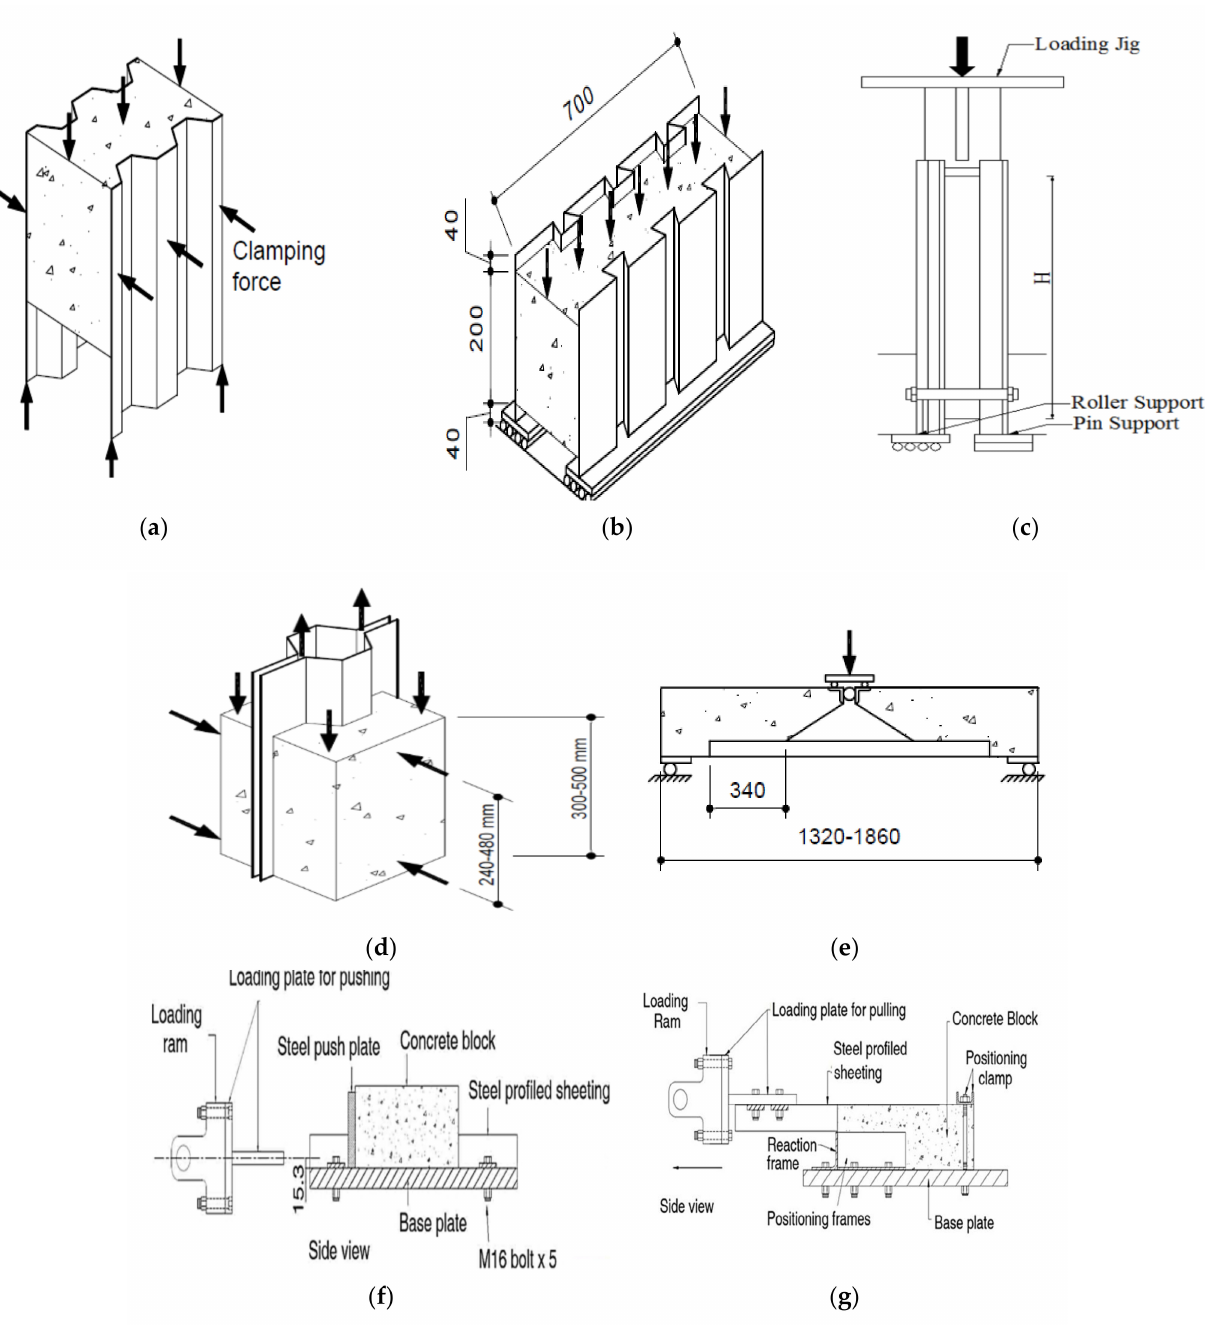
Figure 1. Small-scale test set-ups (dimensions are in mm) . ( a ) Stark (1987). ( b ) Burnet (1998). ( c ) Rana (2016a). ( d ) Daniels (1988). ( e ) An (1993). ( f ) Yi et al. (2021a). ( g ) Yi et al. (2021a). Other studies adopted horizontal-loaded test setups [45,51]. Concrete is cast on the profiled steel sheet, so the concrete self-weight reflects the composite interaction at